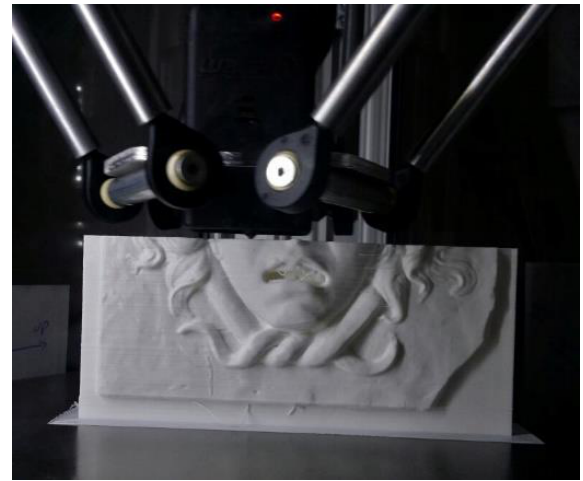
Figure 14. During 3D print of the Medusa mask